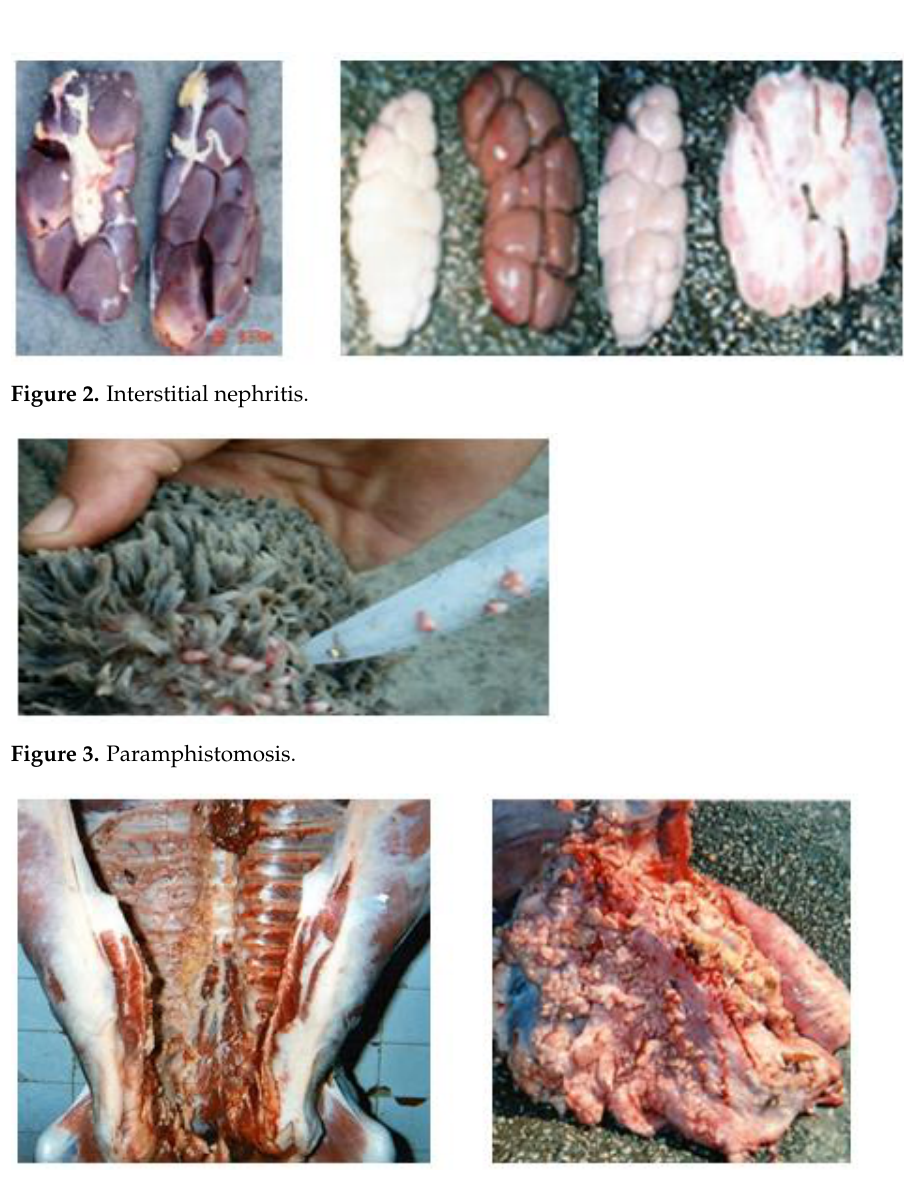
Figure 6. Pericarditis (Pale, sometimes whitish edematous pericardium).